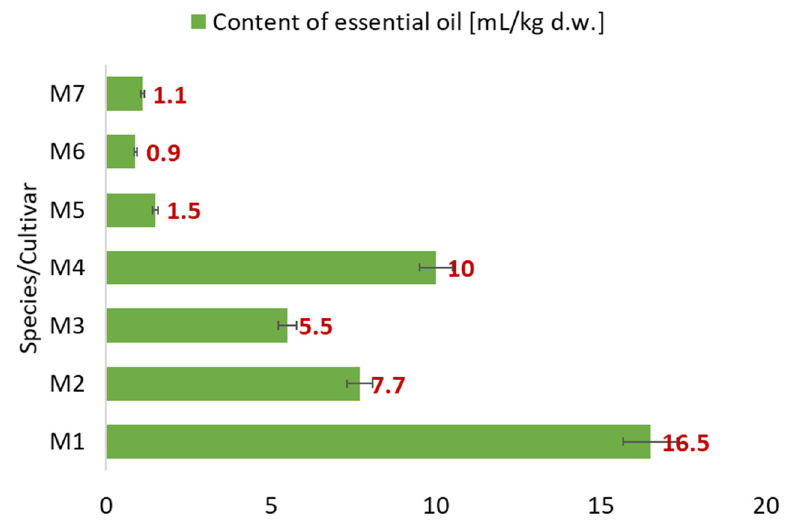
Figure 1. Essential oil content in analyzed mint samples obtained by HD method: M1 Mentha × piperita var. officinalis f. pallescens Camus ‘Swiss’, M2 Mentha × piperita f. citrata ‘Grapefruit’, M3 Mentha × piperita f. citrata , M4 Mentha × carinthiaca Host., M5 Mentha dulcia citreus Hillary’s Sweet Lemon, M6 Mentha longifolia var. schimperi Briq., and M7 Mentha longifolia L.; d.w., dried weight; n = 3.